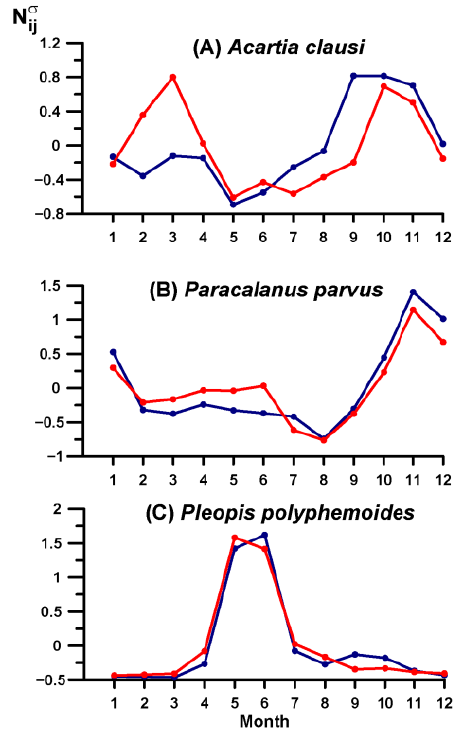
Figure 4. The patterns of seasonal dynamics of eurythermalcrustaceansin Sevastopol Bay at station 1 (blue) and station 2 (red) presented as normalized average monthly values (see details of the method in Section 2.4): ( A ) — Acartia clausi ; ( B ) — Paracalanus parvus ; ( C ) — Pleopis polyphemoides .